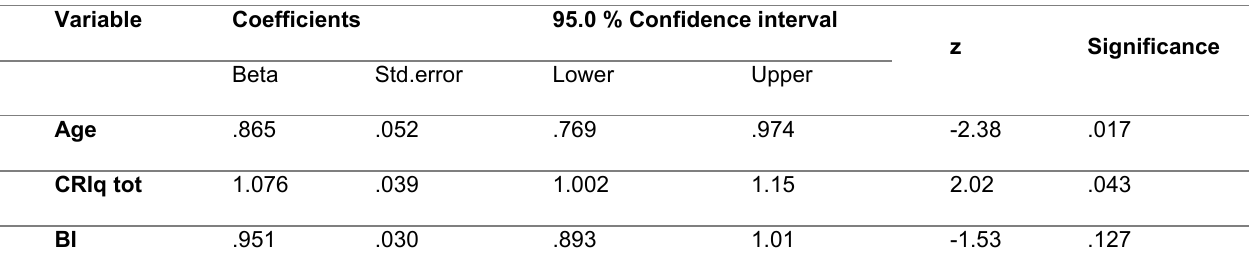
Logistic Regression Analysis for Telerehabilitation